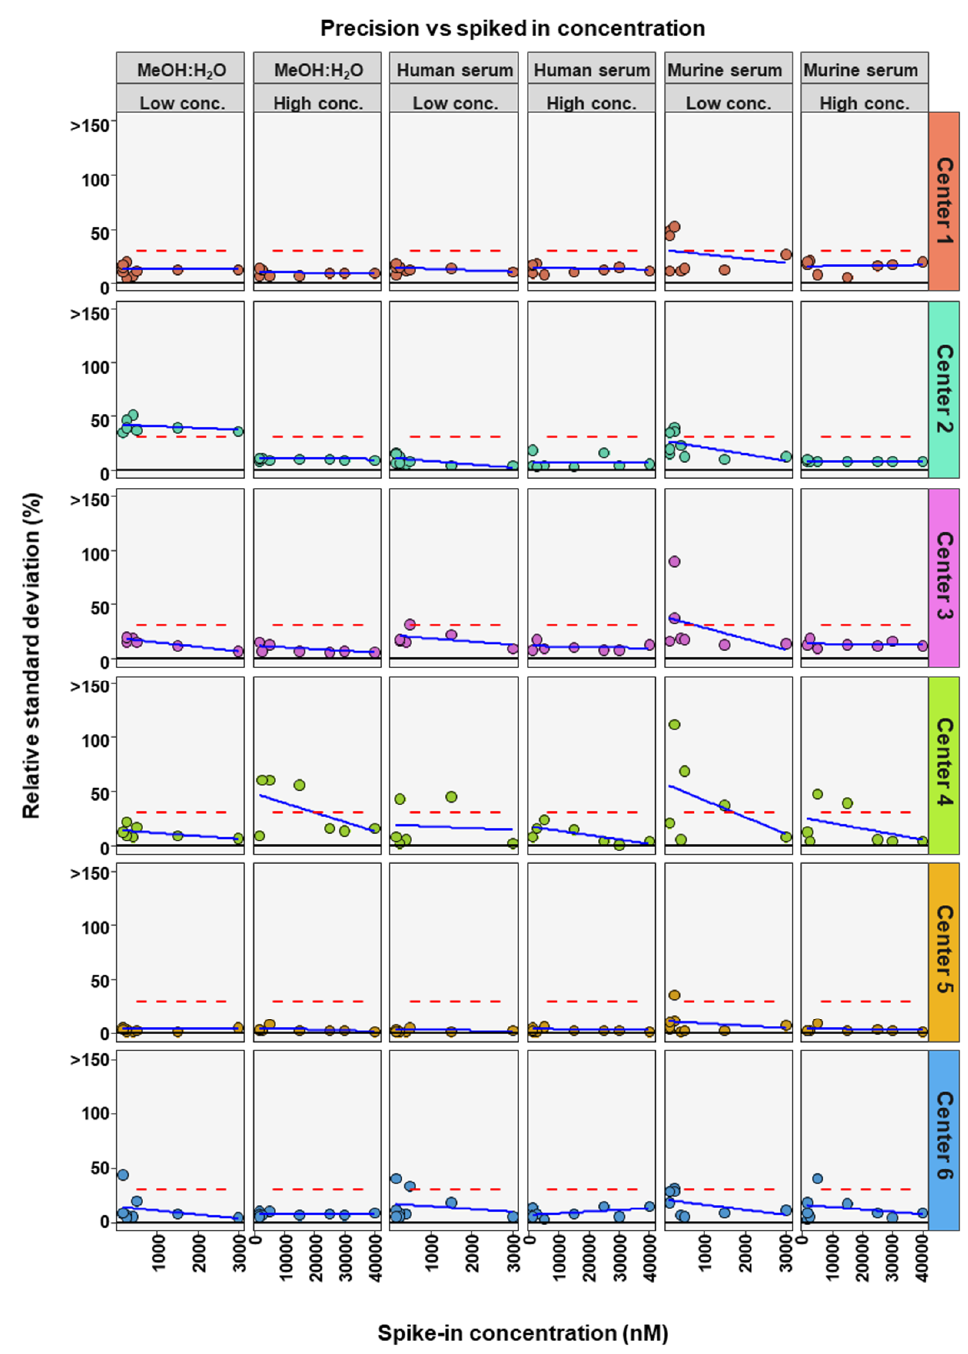
Figure 4. Comparison of spiked concentration of bile acids to precision of measurements for each assessing center.